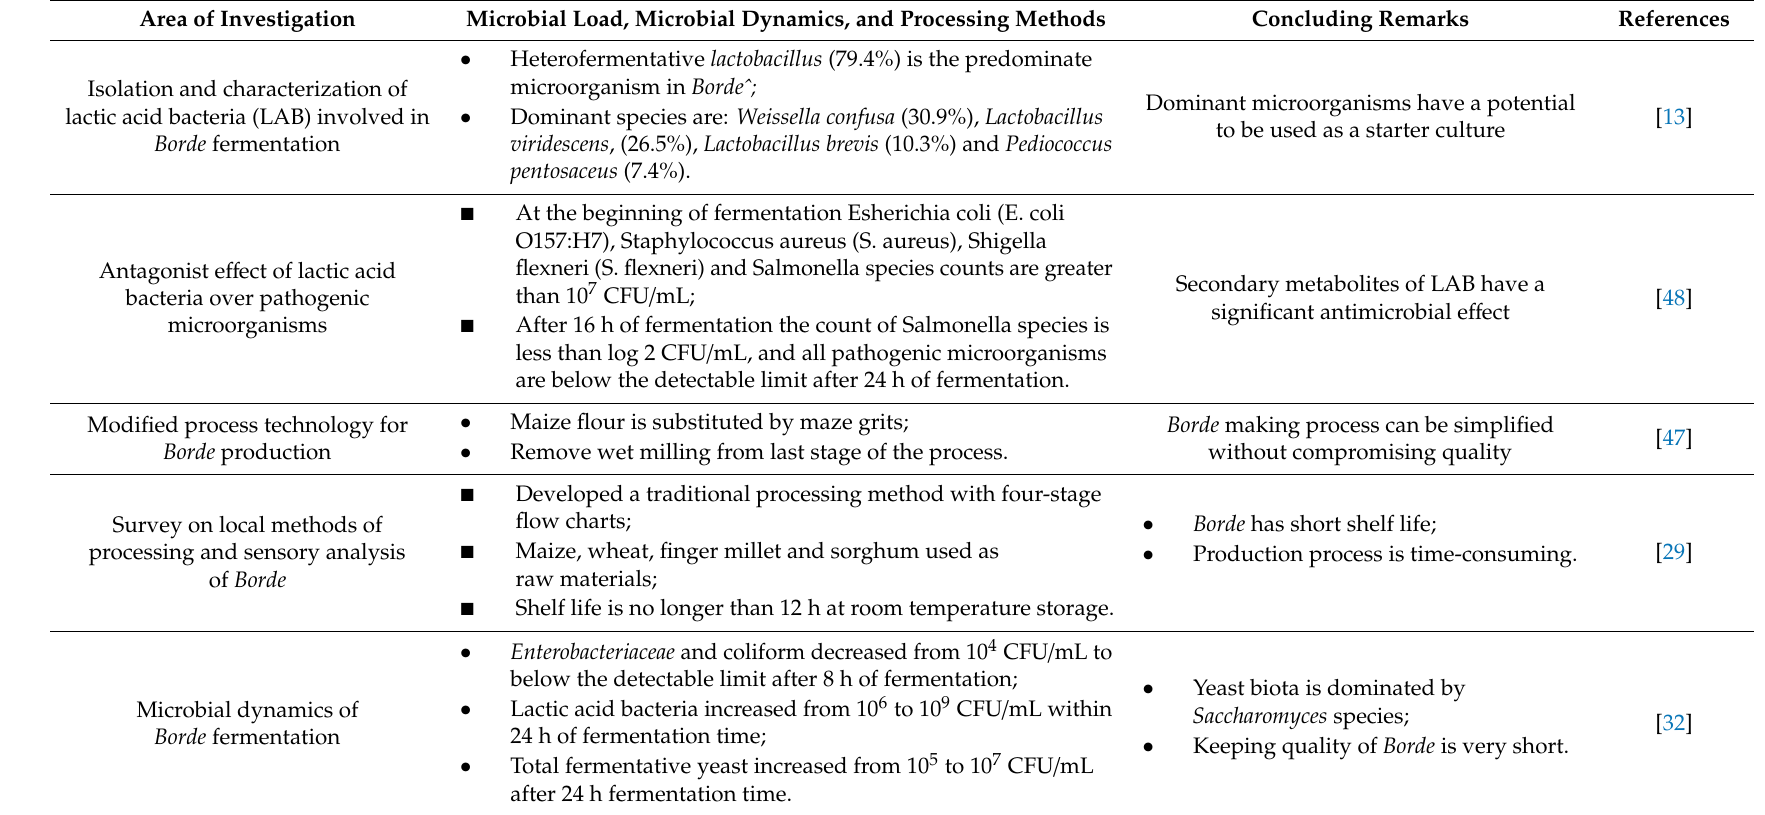
Table 3. Processing methods and microbiological properties of